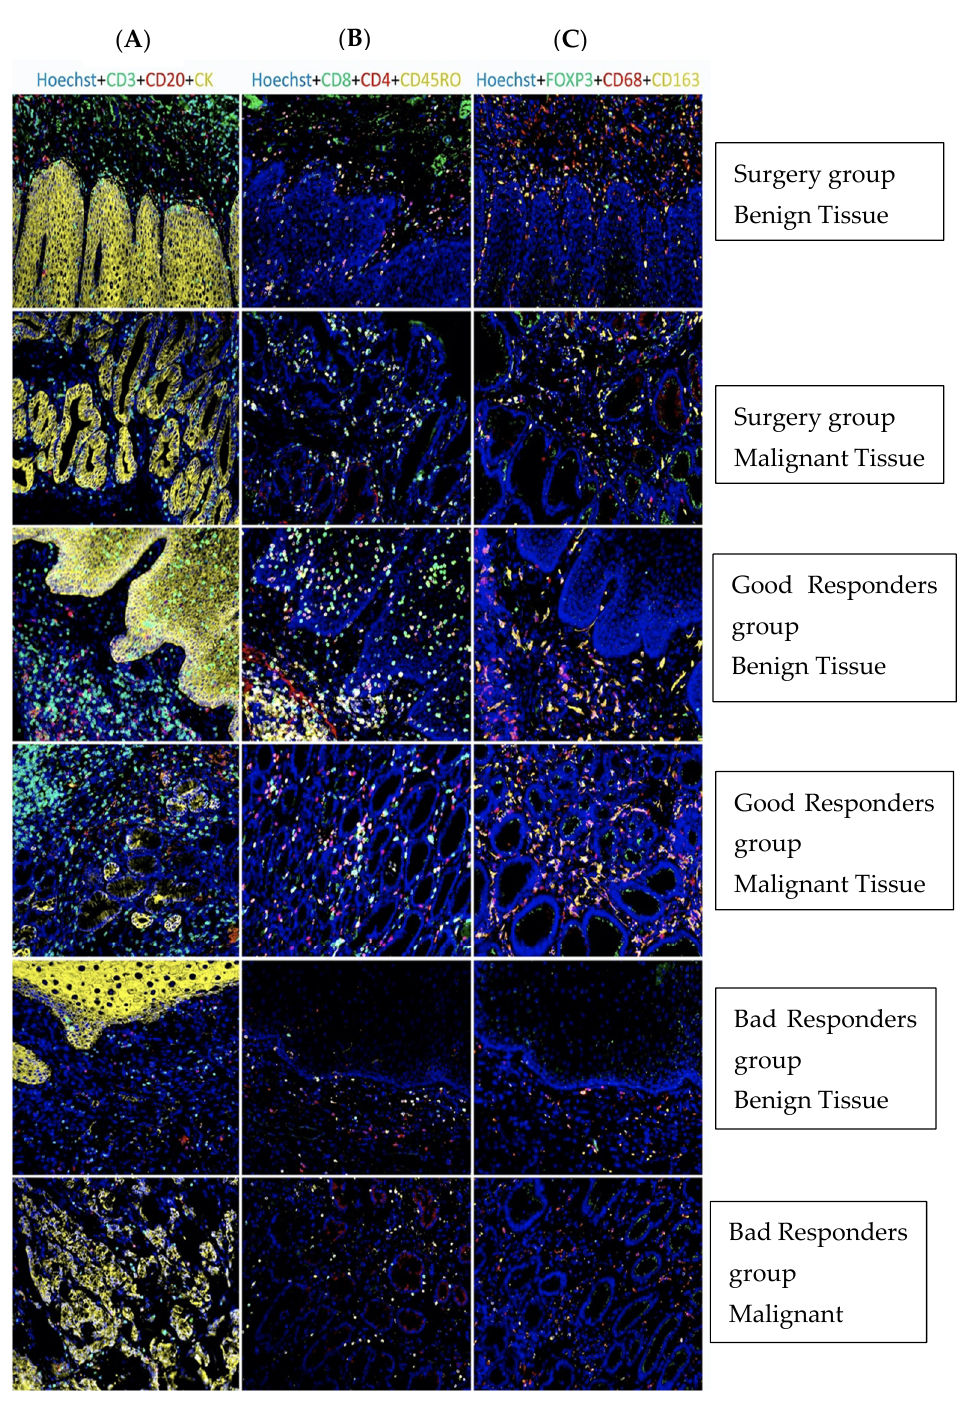
Figure 3. Representative graphic quantification of tumor-infiltrating lymphocytes in the tumor microenvironment of different groups in the cohort. Column ( A ): CD3 + TIL is marked in green, CD20 + TIL in red, and CK-cytokeratin is marked in yellow; Column ( B ): CD8 + TIL is marked in green, CD4 + TIL in red, and CD45RO + TIL in yellow; Column ( C ): Foxp3 + TIL is marked in green, CD68+ in red, and CD163+ in yellow.